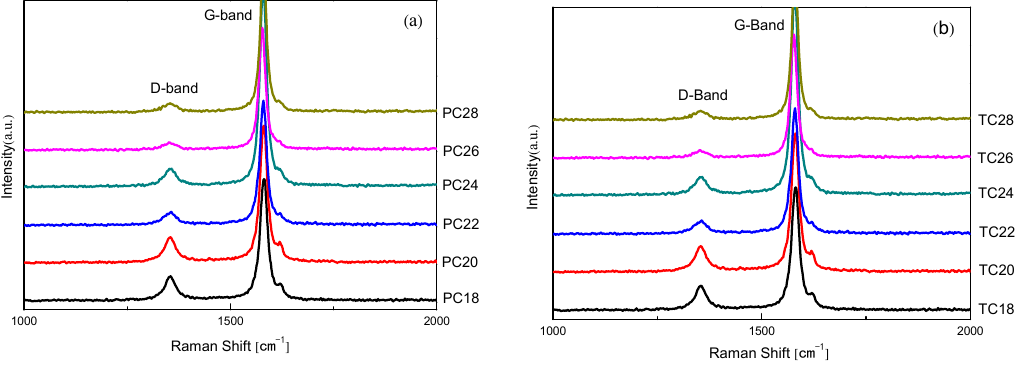
Figure 5. Raman spectra of two kinds of coke anode materials at different temperatures. ( a ) Raman spectra of petroleum coke at different temperatures; ( b ) Raman spectra of pitch coke at different temperatures. Table 4. Raman structural analysis of two anode materials at different temperatures.